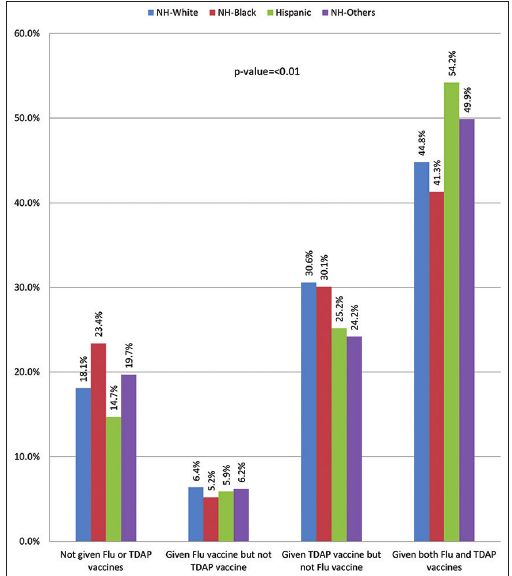
Figure 2 : Flu and TDAP vaccine acceptance by patient’s